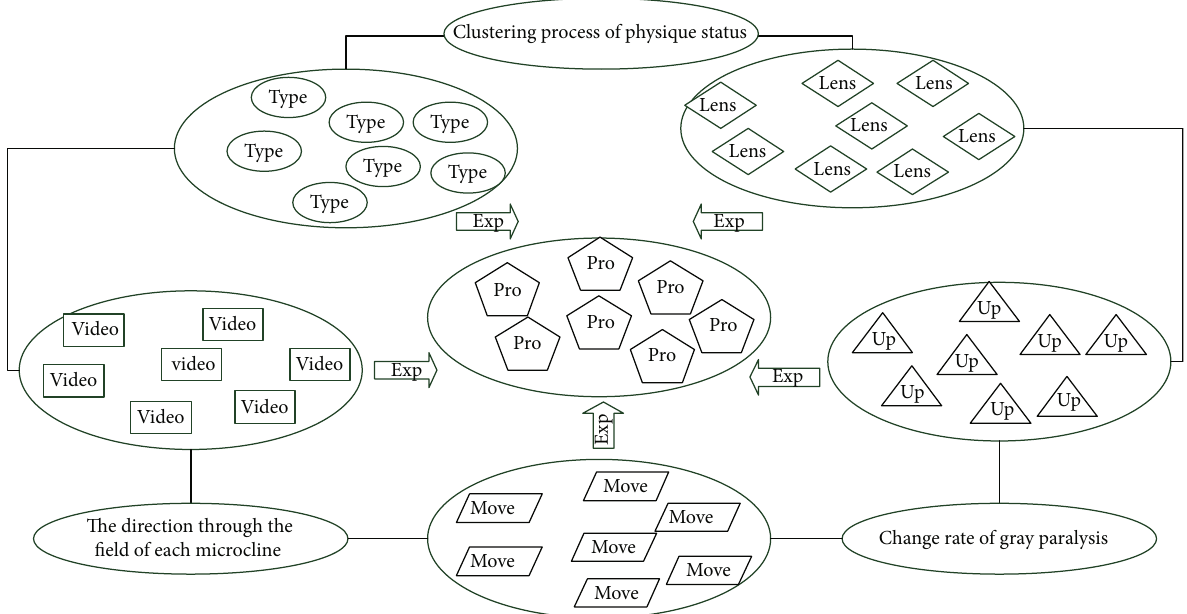
Figure 3: Image decomposition and clustering process of physique status.